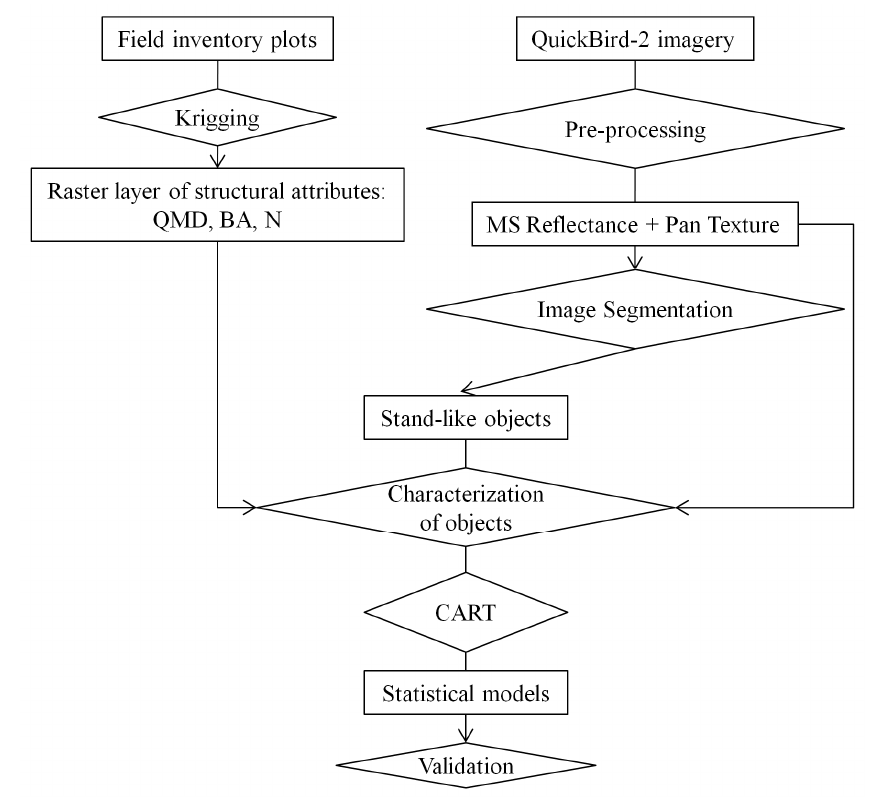
Figure 1. Schematic methodology followed in the